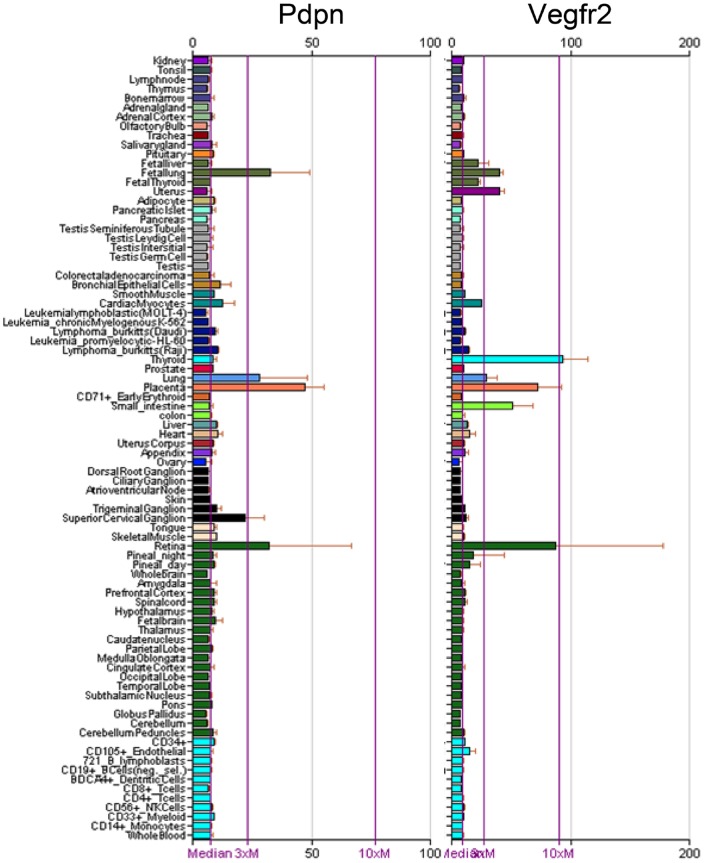
Comparison of Pdpn and Vegfr2 (Kdr) mRNA expression in human tissues.Values from Affymetrix probe sets representing Pdpn and Vegfr2 are shown as presented on BioGPS (http://biogps.gnf.org).